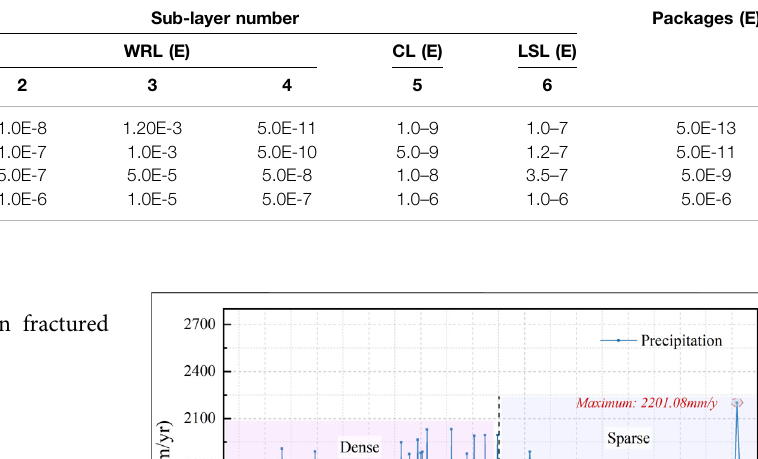
TABLE 2 | Hydraulic conductivity of covering sub-layers and packages under different states (unit: m/s). States